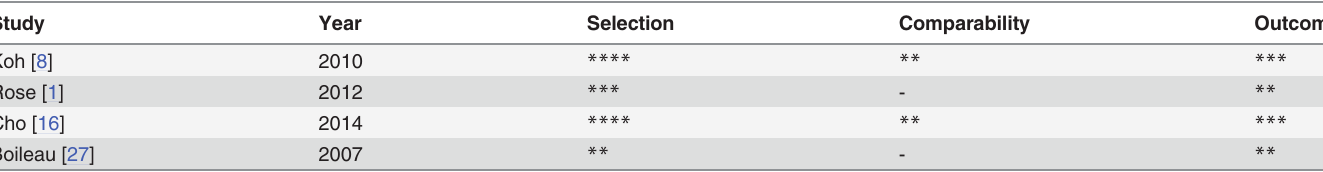
Table 4. Cohort study quality rating (determined using the Newcastle – Ottawa scale).